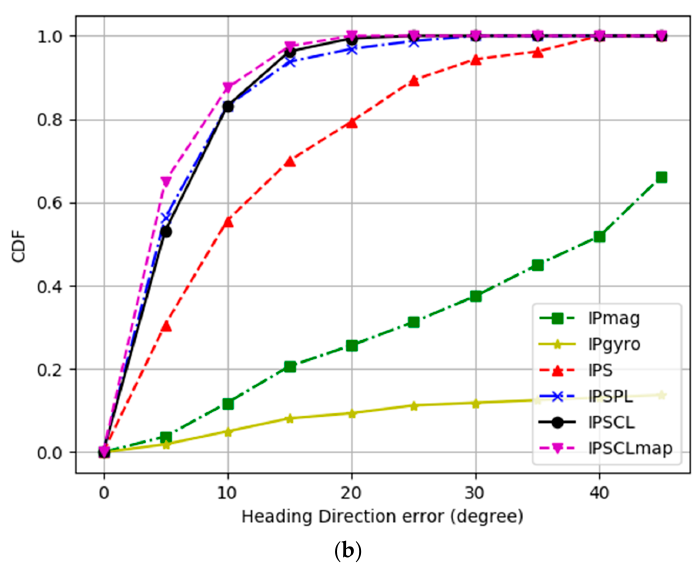
Figure 5. ( a ) Heading direction as a function of the path; ( b ) cumulated heading direction error for the ground-truth reference heading direction. Table 1. Maximum, minimum, and average heading direction error of